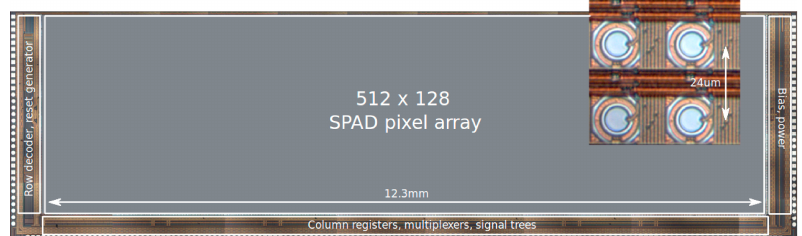
Figure 6. Photomicrograph of the sensor; it was fabricated in a 0.35 µm CMOS process with a pitch of 24 µm. The inset shows a detail of four pixels achieving a fill factor of 5%.